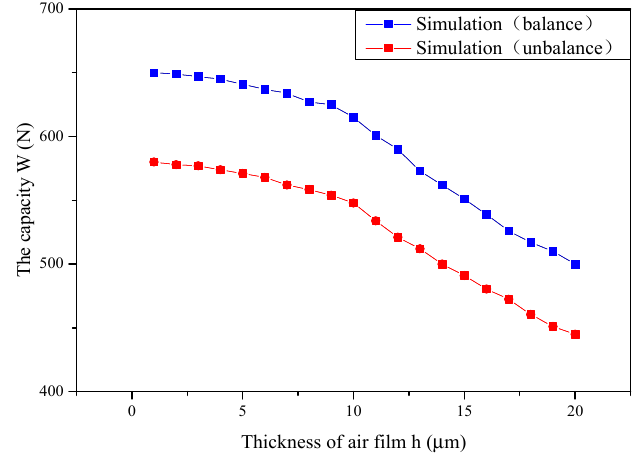
Figure 13. Variation curves of the bearing capacity with the thickness of air films. Figure 14 shows the comparison of the static stiffness values calculated for different states. It can be seen that the static stiffness in the unbalanced condition is higher than that in the balanced condition at the same upper air film thickness. This is because the low-pressure zones exist immediately adjacent to the throttle holes when the air film is in the unbalanced state. In addition, with the increasing thickness of the air film, the static stiffness rises and then drops. The inflection point of the stiffness curve in a balanced state occurs when the thickness of an air film reaches 10 µ m, while the inflection point for an unbalanced state occurs at an air film thickness value of 11 µ m. The variation in the static stiffness is caused by the rarefaction effect of the air film, which improves the stability of aerostatic guideway when the gap generating the air film is small. Meanwhile, the maximum stiffness in an unbalanced state is higher by 16.67 percent relative to a balanced state.